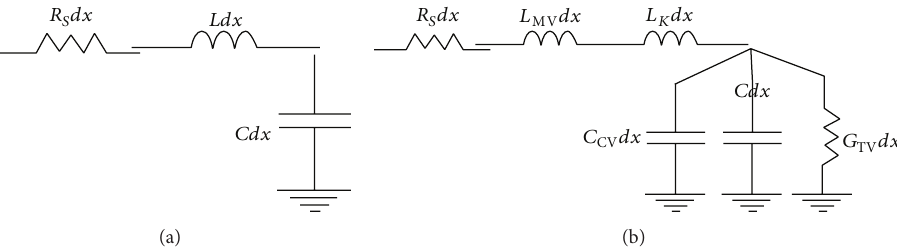
Figure 6: Segments of a transmission line modeled interconnect: (a) RLC model (b) RLGC